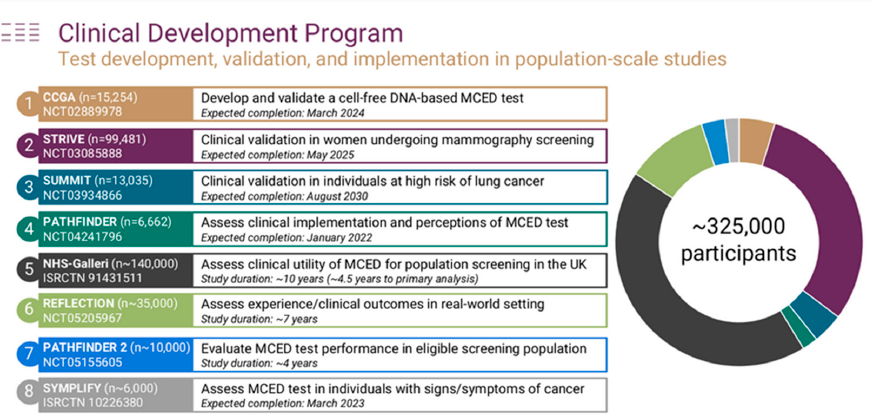
Figure 2. Clinical Development Program of a cfDNA-based Multicancer Early Detection (MCED) Test.